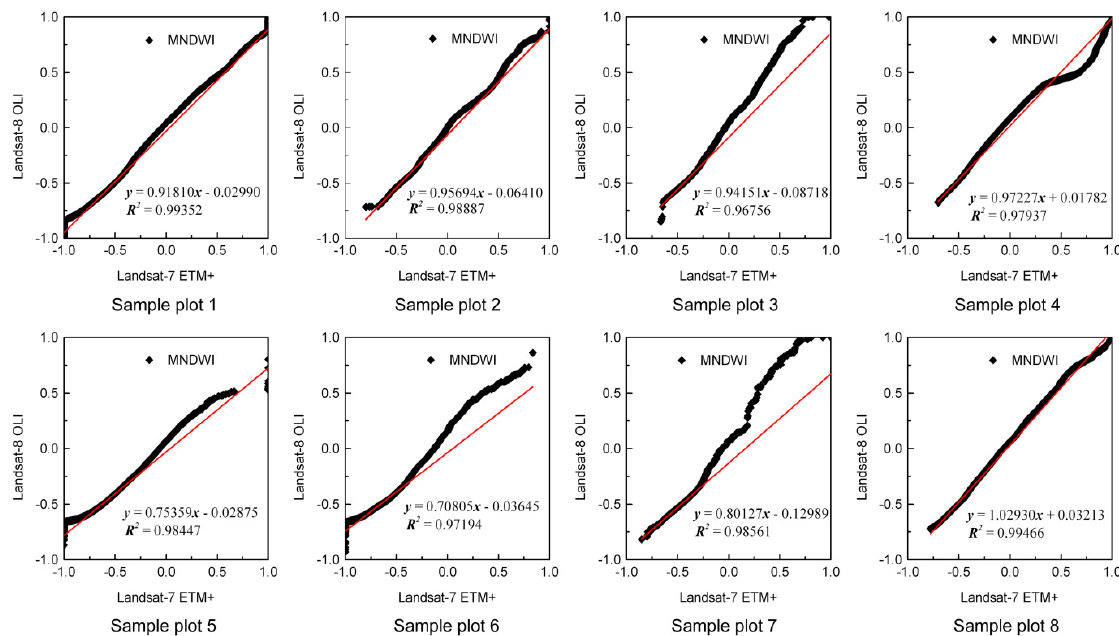
Figure 10. Statistical relationship between Landsat-7 ETM+ and Landsat-8 OLI MNDWI values for the eight sample plots. The linear regression equation and R 2 value are given in each plot. The red solid line refers to the linear fitting curve.